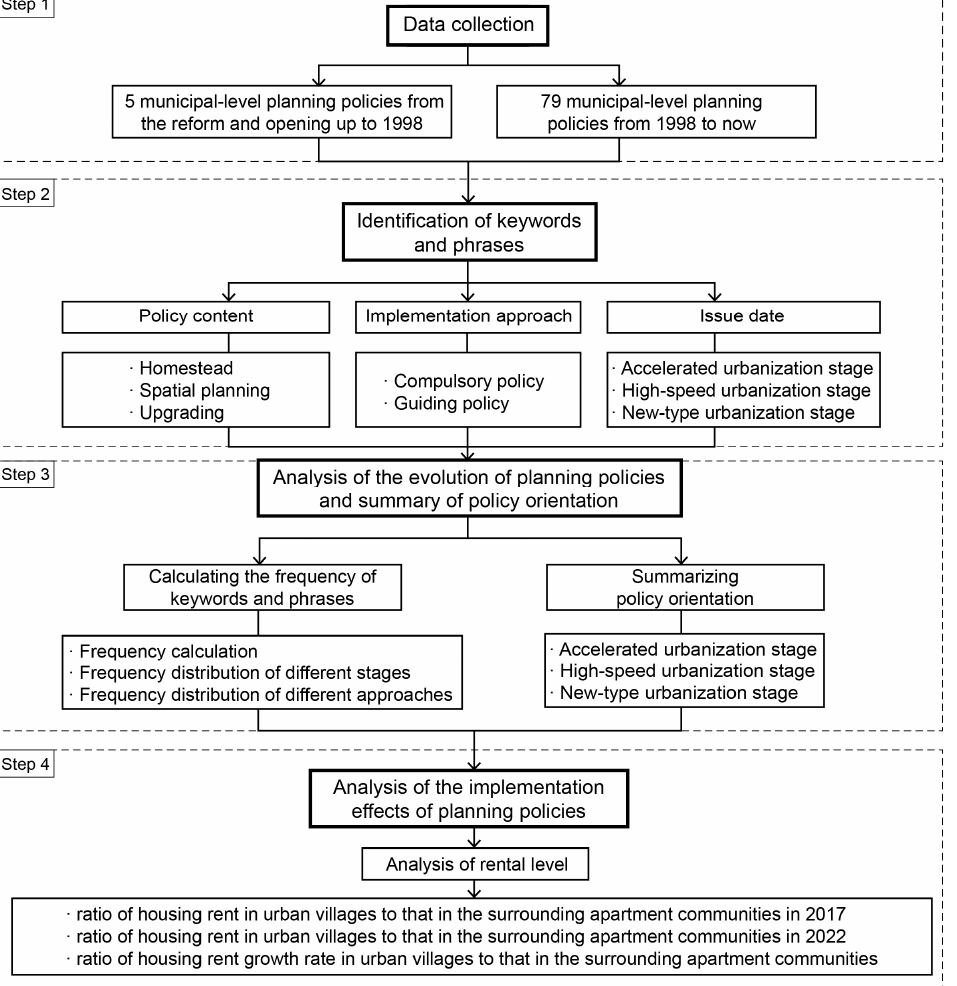
Figure 4. Methodological framework.